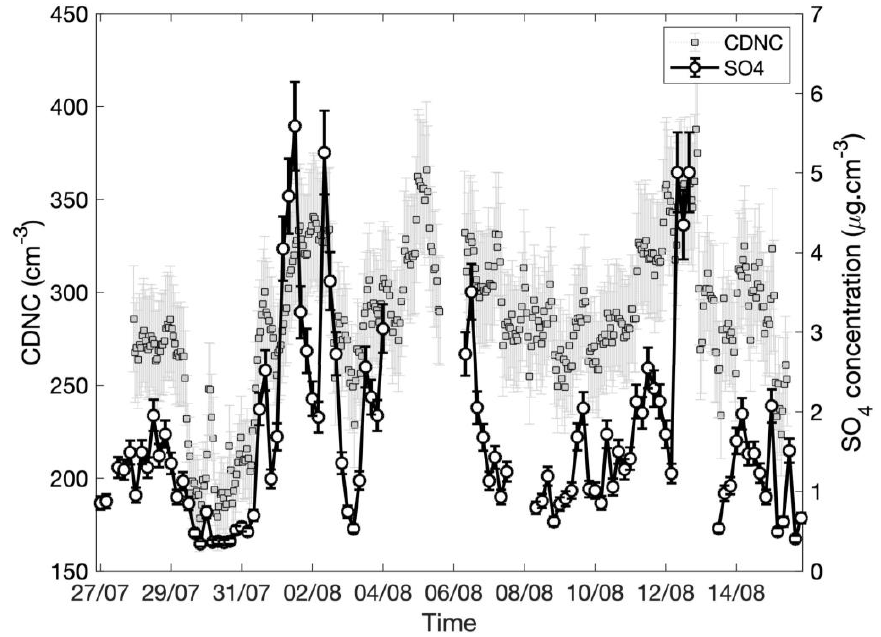
Figure 1. Sulfate mass concentration and cloud droplet number concentration (CDNC) measured within the cloud chamber (CHIEF) during the indicated intensive operational period in summer 2007.